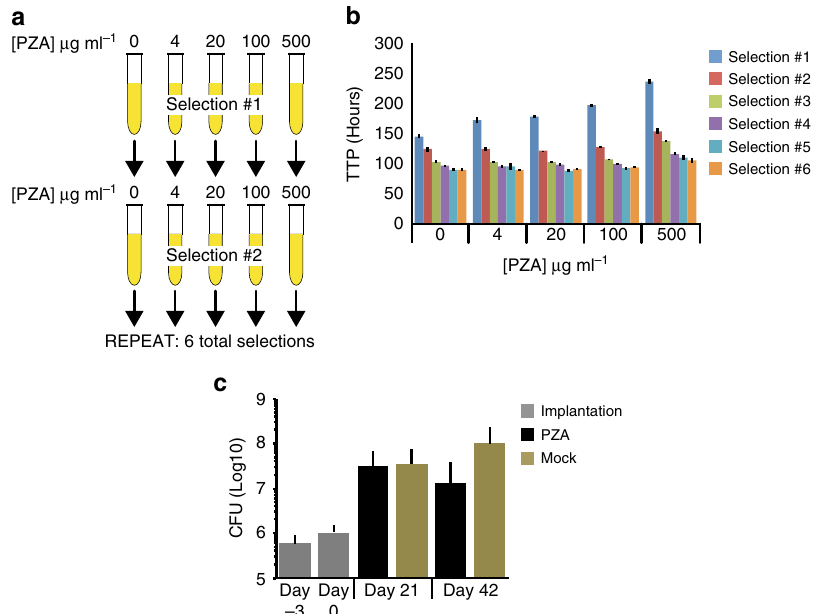
Fig. 2 Pyrazinamide selection screens in vitro and during infection in mice. a Schematic diagram of the sequential in vitro pyrazinamide ( PZA ) selection screen. b Mean time-to-positivity ( TTP ; hours) of three biological replicates and standard deviations for each round of in vitro selection. c Mean and standard deviations of bacterial burdens (colony-forming units CFU ) observed in the spleens of mice at day − 3 (implantation; gray ), day 0 (start of pyrazinamide treatment; gray ) and after 21 and 42 days of pyrazinamide ( PZA ; black ) or mock ( brown ) treatment. Five mice per time-point were